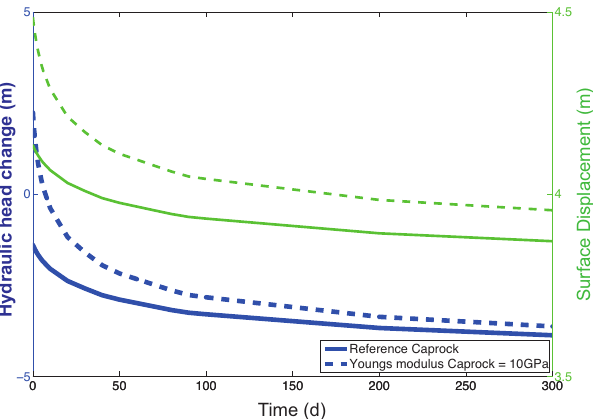
Figure 16. Central vertical surface deformation and hydraulic head change with time for the pyroclastic aquifer overlain by different cap rocks, showing the effect of a sign-flipped strain in comparison to the reference